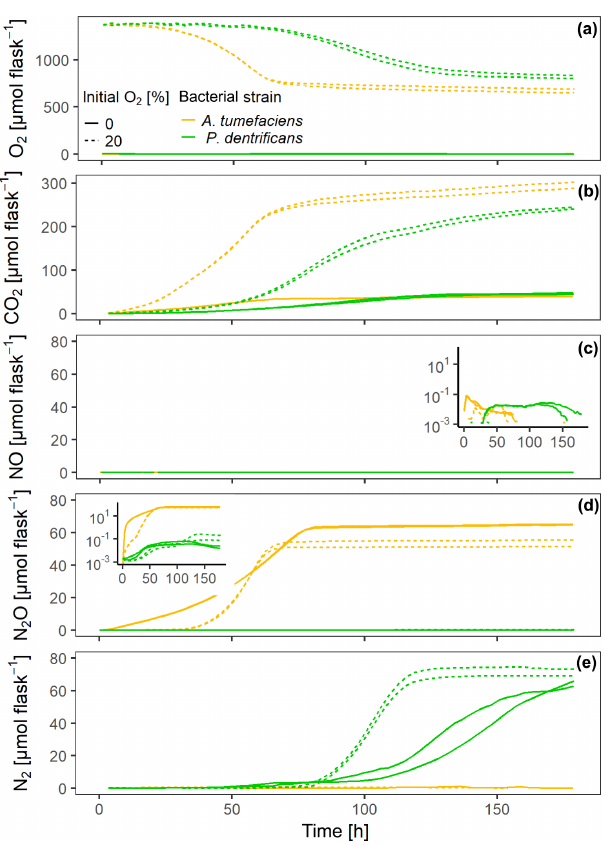
Figure 2. Gas kinetics of individual sets of hotspots that were loosely placed in empty flasks (50 each), saturated with a growth medium and inoculated with two different bacterial strains – either a full denitrifier (P. denitrificans ) or a truncated denitrifier lacking N2O reductase ( A. tumefaciens ) – under oxic and anoxic conditions: (a) O 2 , (b) CO 2 , (c) NO, (d) N 2 O, (e) N 2